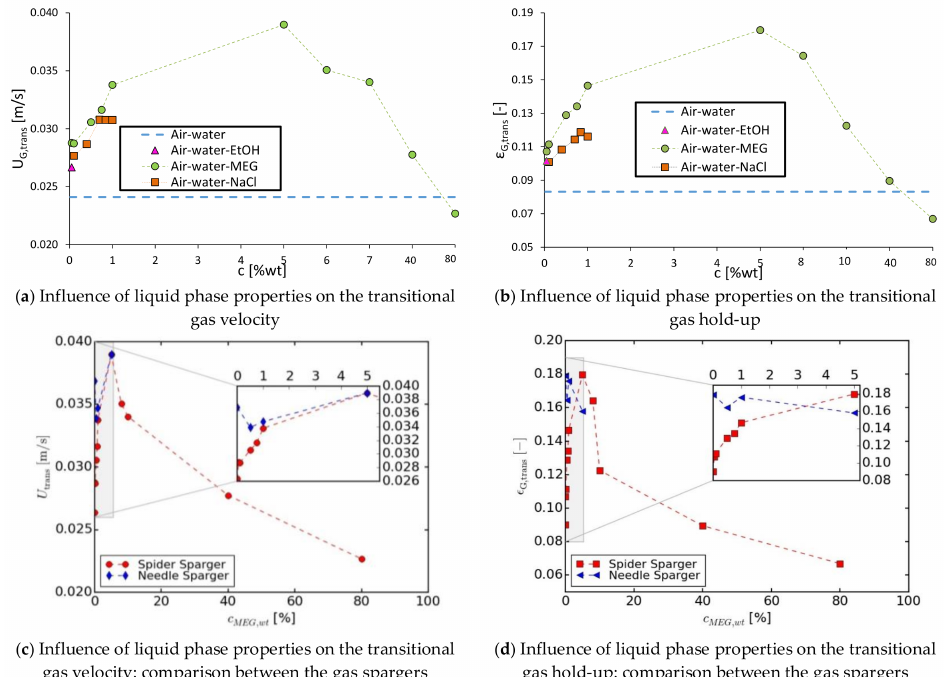
Figure 9. Influence of the liquid phase on flow regime transition points—ref.